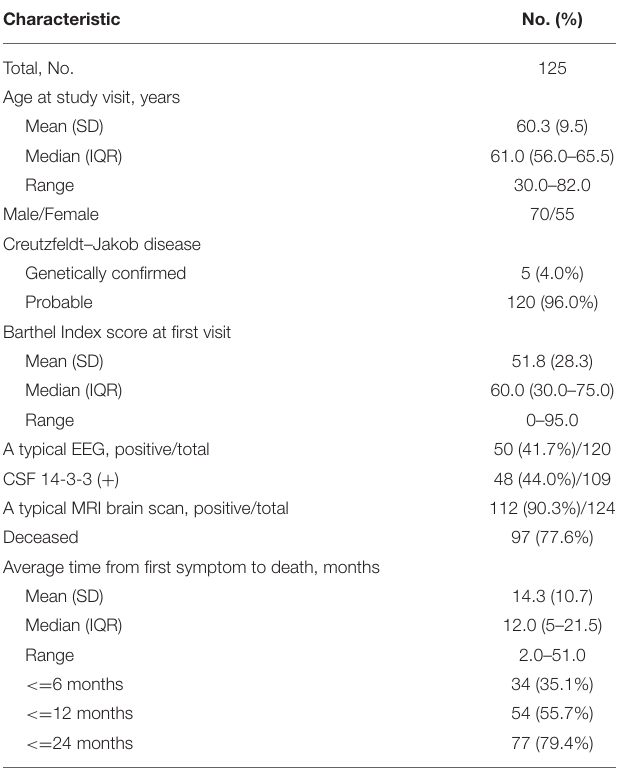
TABLE 1 | Participant demographic and clinical